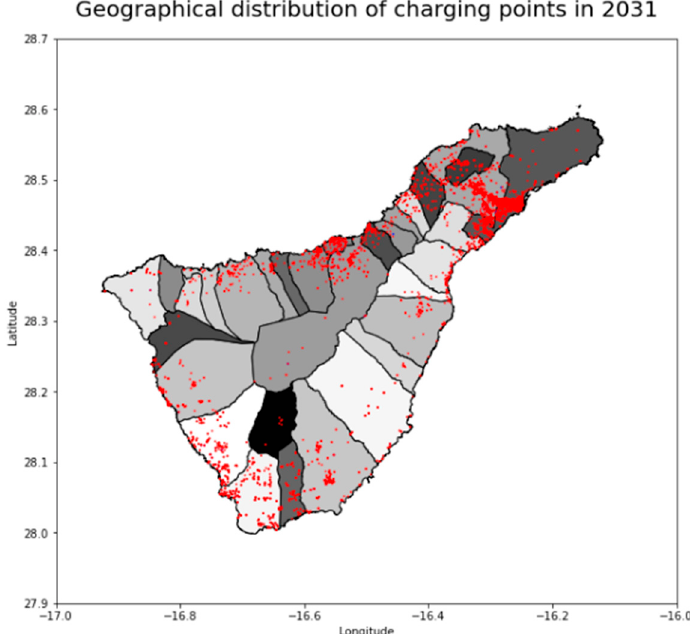
Figure 14. Map of the distribution of the charging points obtained in Tenerife for the year 2031.